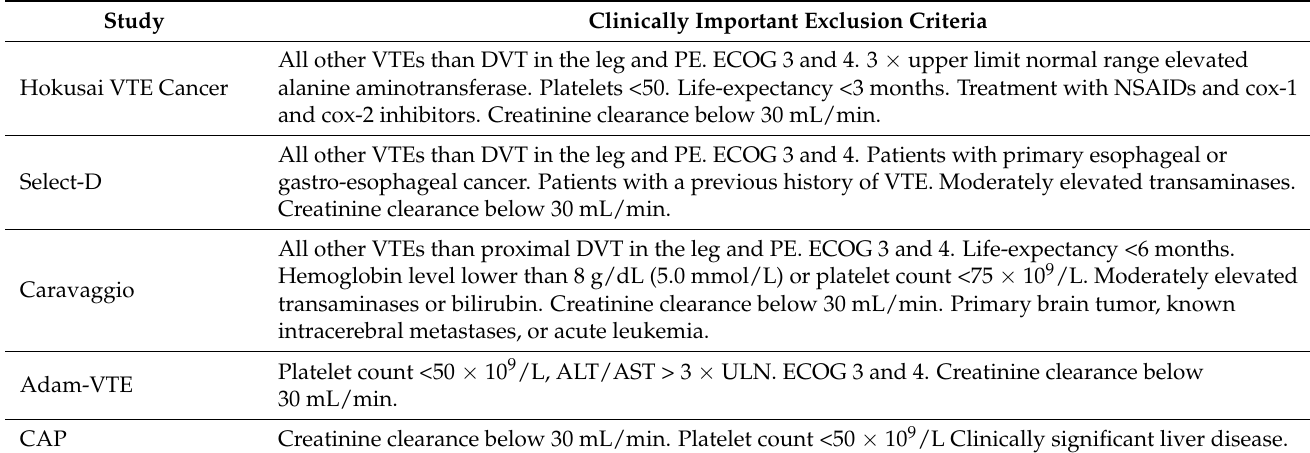
Table 4. Patients excluded from the clinical